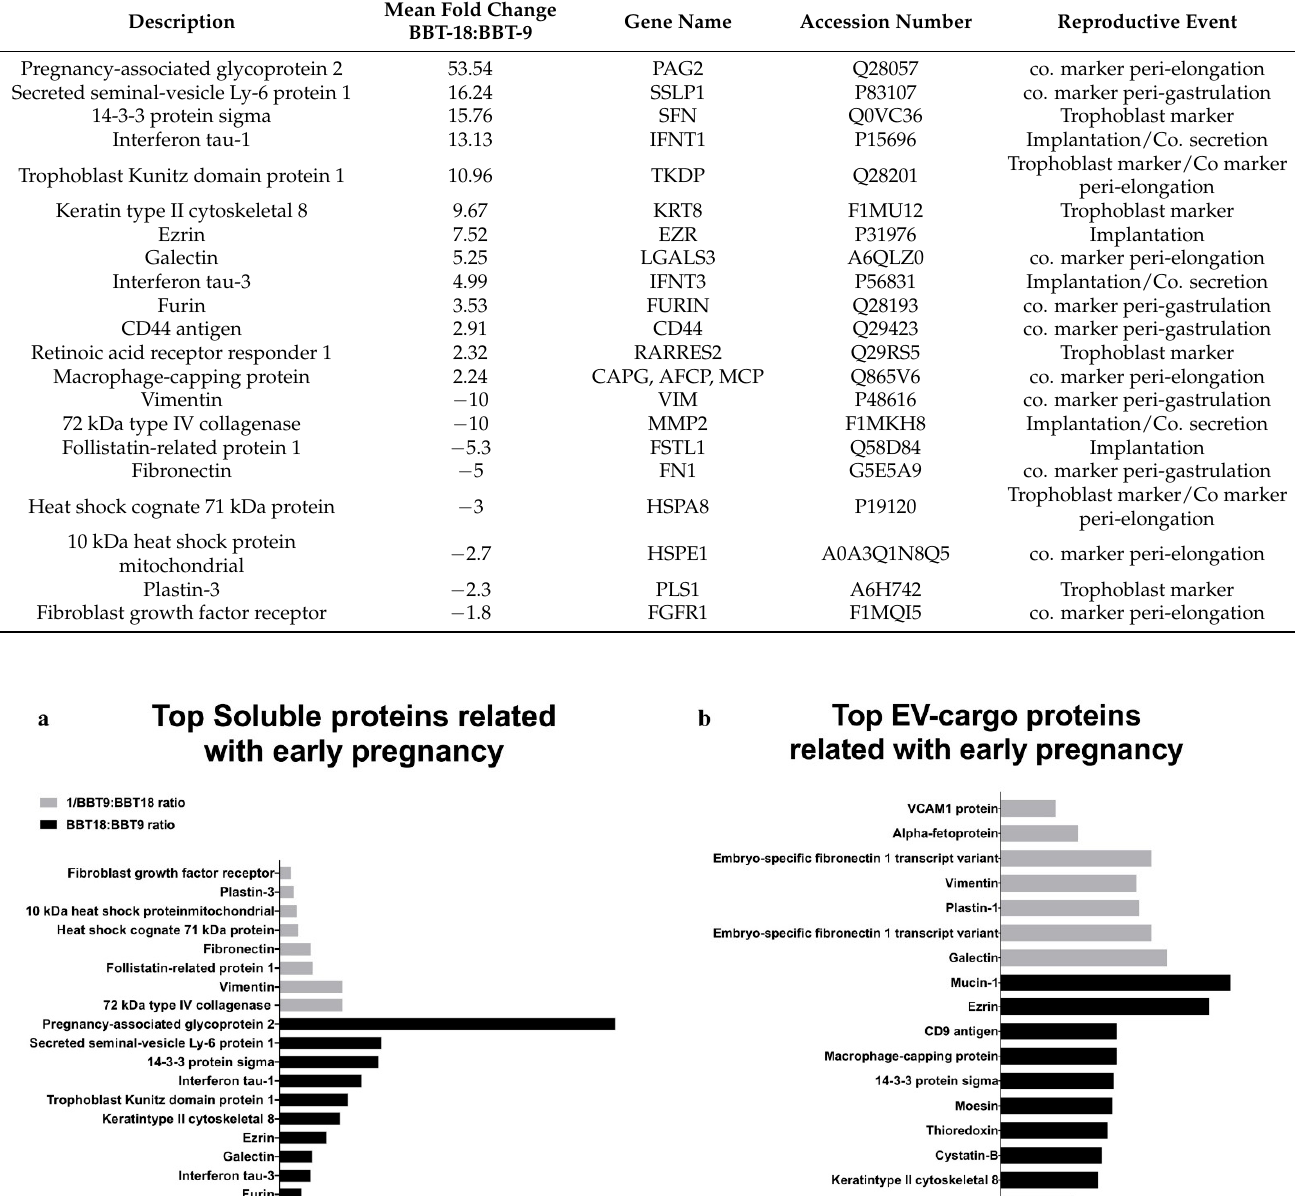
Figure 4. Maternal MSCs show chemotactic migration to BBT-9- or BBT-18-secretome. Analysis of the chemotactic effect on rose diagrams of eMSC and pbMSC without stimuli (control) or stimulated by EVs or soluble proteins from BBT-9- or BBT-18-secretome ( a ). The maximum Euclidean distance (MED) of eMSC or pbMSC towards EVs or soluble proteins from BBT-9 or BBT-18 was measured (mean ± SD). Different letters indicate a significant difference. * p < 0.05; ** p < 0.005; **** p < 0.0001. ( b ). The center of mass (COM): a strong chemotactic migration parameter for the analysis of the migrating re- sponse of eMSC and pbMSC towards EVs or soluble proteins from BBT-9 or BBT-18. Charts showing the trajectory plots marking each cell track with its endpoint ( c ), or the center of mass length ( d ), of eMSC and pbMSC without stimuli (control) or stimulated by EVs or soluble proteins from BBT-9 or BBT-18. The velocity of eMSC or pbMSC towards EVs or soluble proteins from BBT-9 or BBT-18 was measured (mean ± SD). Different letters indicate a significant difference ( e ).